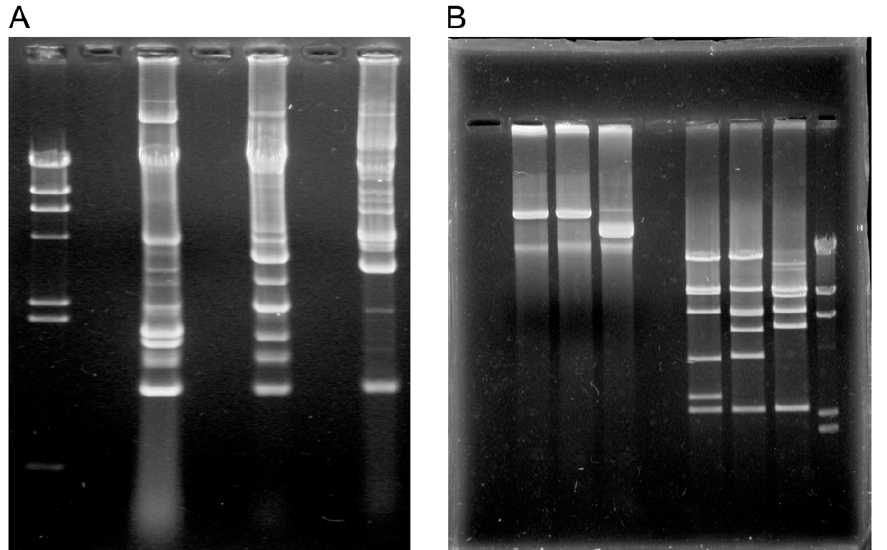
Figure 1. Capture of IncX-replicon plasmids. Agarose gel electrophoresis of (a) plasmid purification of strains Shigella sp. MO17, MO440 and LN126, respectively, followed by (b) plasmid purifications of IncX-replicon positive transformants of Entranceposon derivatives of the same strains. The leftmost three lanes are Eco RI digests of the three first lanes. Based on the sequence analysis, the plasmids of MO17 and MO440 were identified as being identical, only differing by the position of the Entranceposon. This difference in Entranceposon insertion site accounts for the dissimilar band pattern observed within the digested versions of these two plasmids (see text for more details).